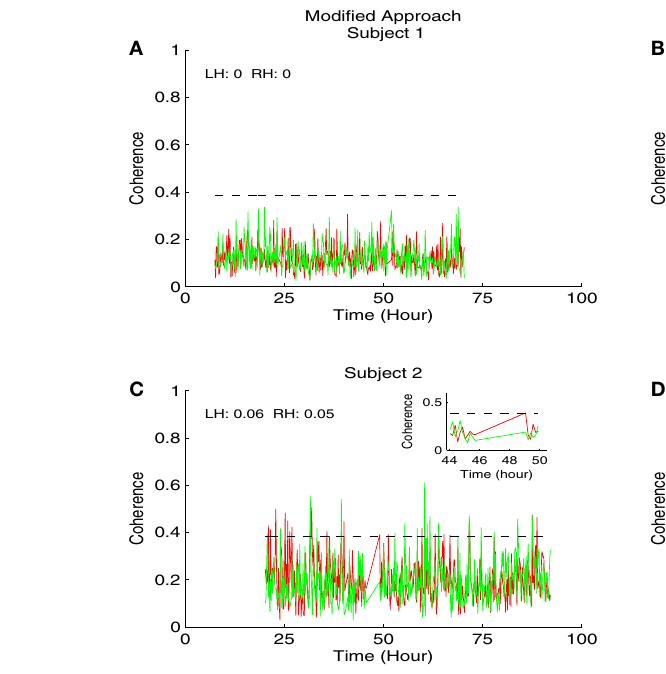
passivity index (PPI) calculated for LH and RH was given in the inset.The horizontal line at the coherence value of 0.384 is the confidence limit for the coherence estimate.We displayed the insets in (C,D) for the portion of the results from the period where the study was stopped at 45.5h and restarted at 49h. At the onset of the break, the modified approach showed no significant coherence while the standard approach showed a significant coherence in both hemispheres. Similarly at 49h after the study was restarted, the modified approach showed coherence only in the left hemisphere while at this point the standard approach showed no significant